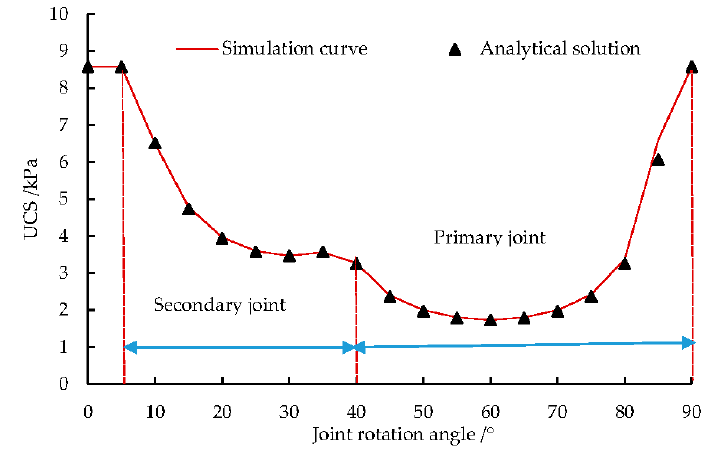
Figure 16. Failure envelope for sample with different joint cohesion values (see Table 4).